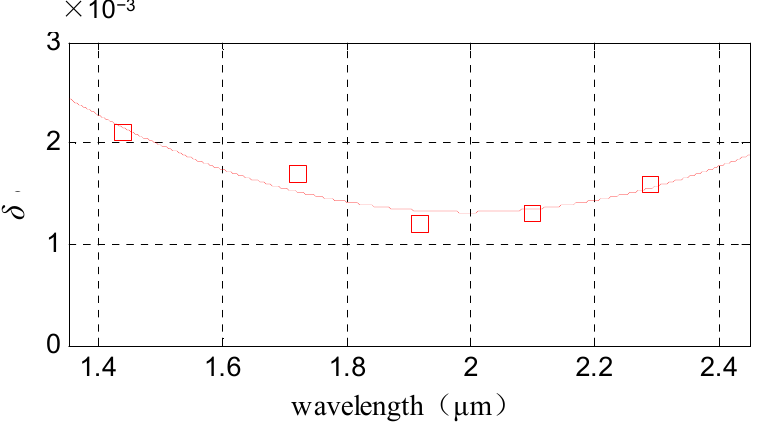
Figure 3. The fitting curve of variable stray light ratio: the horizontal ordinate shows the wavelength with units in micrometers. Additionally, the longitudinal coordinate shows the ratio of variable stray light to signal light, which is represented by “ δ ” in this paper.